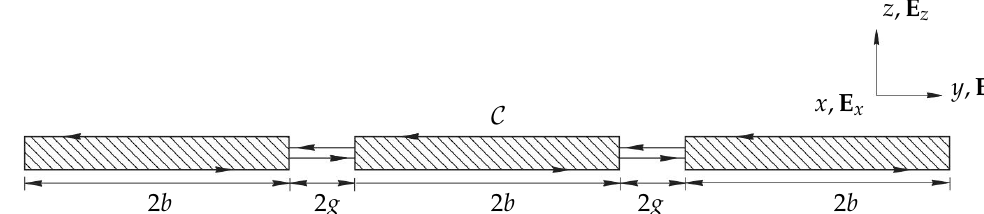
Figure 1. Sketch of the boundary value problem for three oscillating rectangular cross-sectional beams. E x , E y , E z is the vector basis corresponding to the x , y and z coordinate